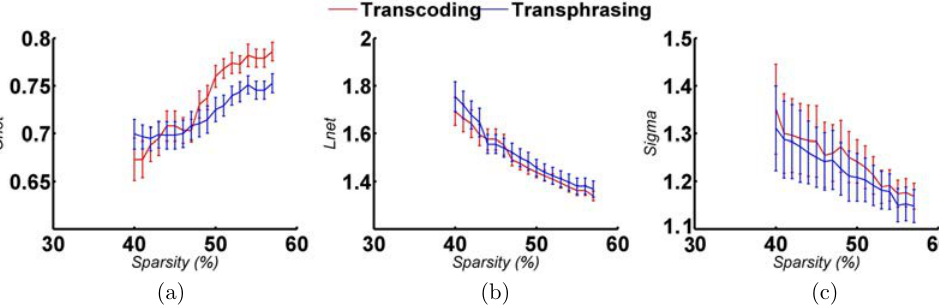
Fig. 8. Comparison of the small-world indicators between the transcoding and transphrasing translation strategy with relative thresholding: (a) the clustering coe±cient, (b) average path length and (c) measure of small-worldness. The curves ð mean (cid:3) SE Þ show the network indicators with di®erent thresholds, in which the red and blue color represent the transcoding and transphrasing strategy respectively. The horizontal axes denote the sparsity values whereas the vertical axes denote the network property indexes.